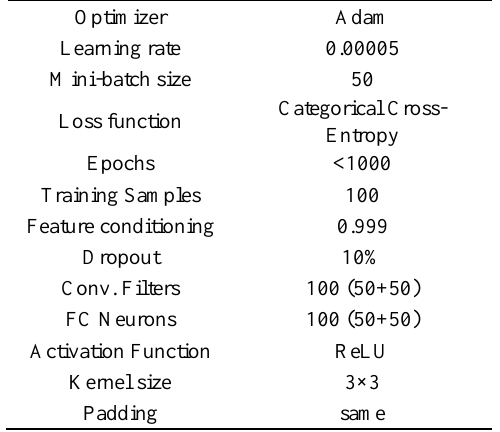
Table 1. Constant parameters used for investigating network performance